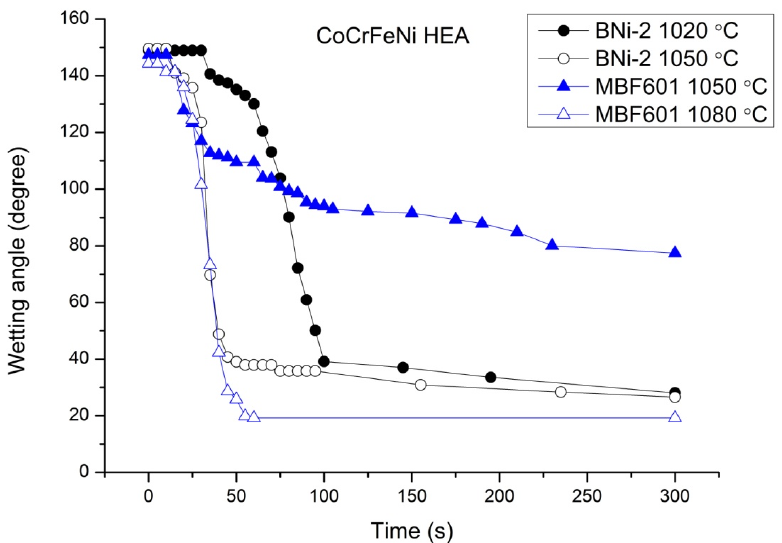
Figure 3. Wetting angle measurements of BNi-2 and MBF601 filler alloys on the CoCrFeNi.